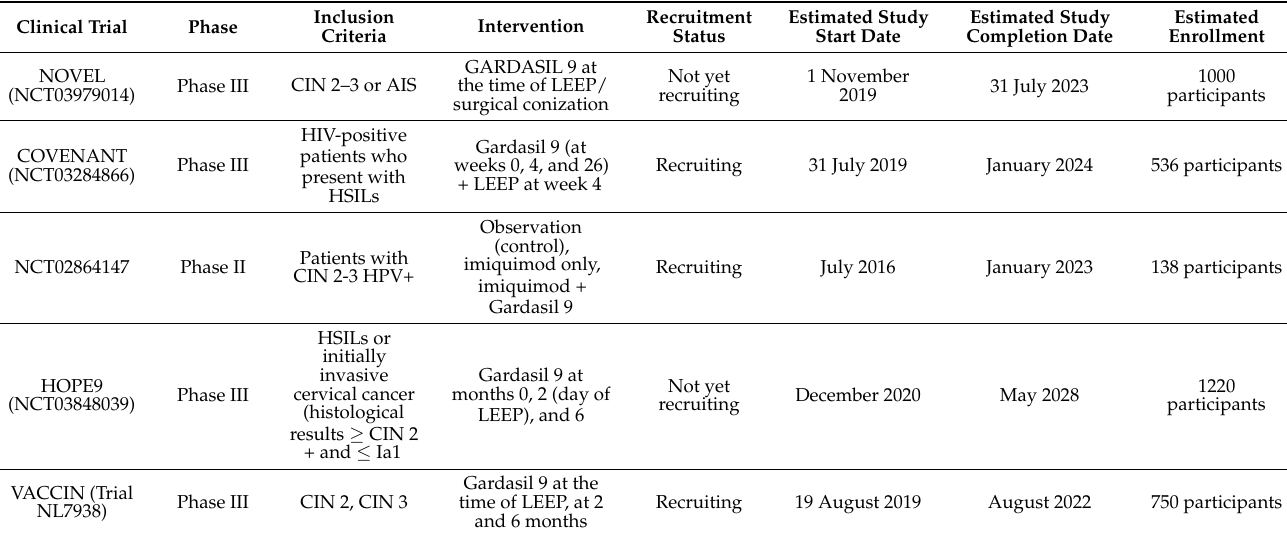
Table in accordance with the available data as of 22 April 2022. AIS—adenocarcinoma in situ, HSIL—high-grade squamous intraepithelial lesion, CIN—cervical intraepithelial